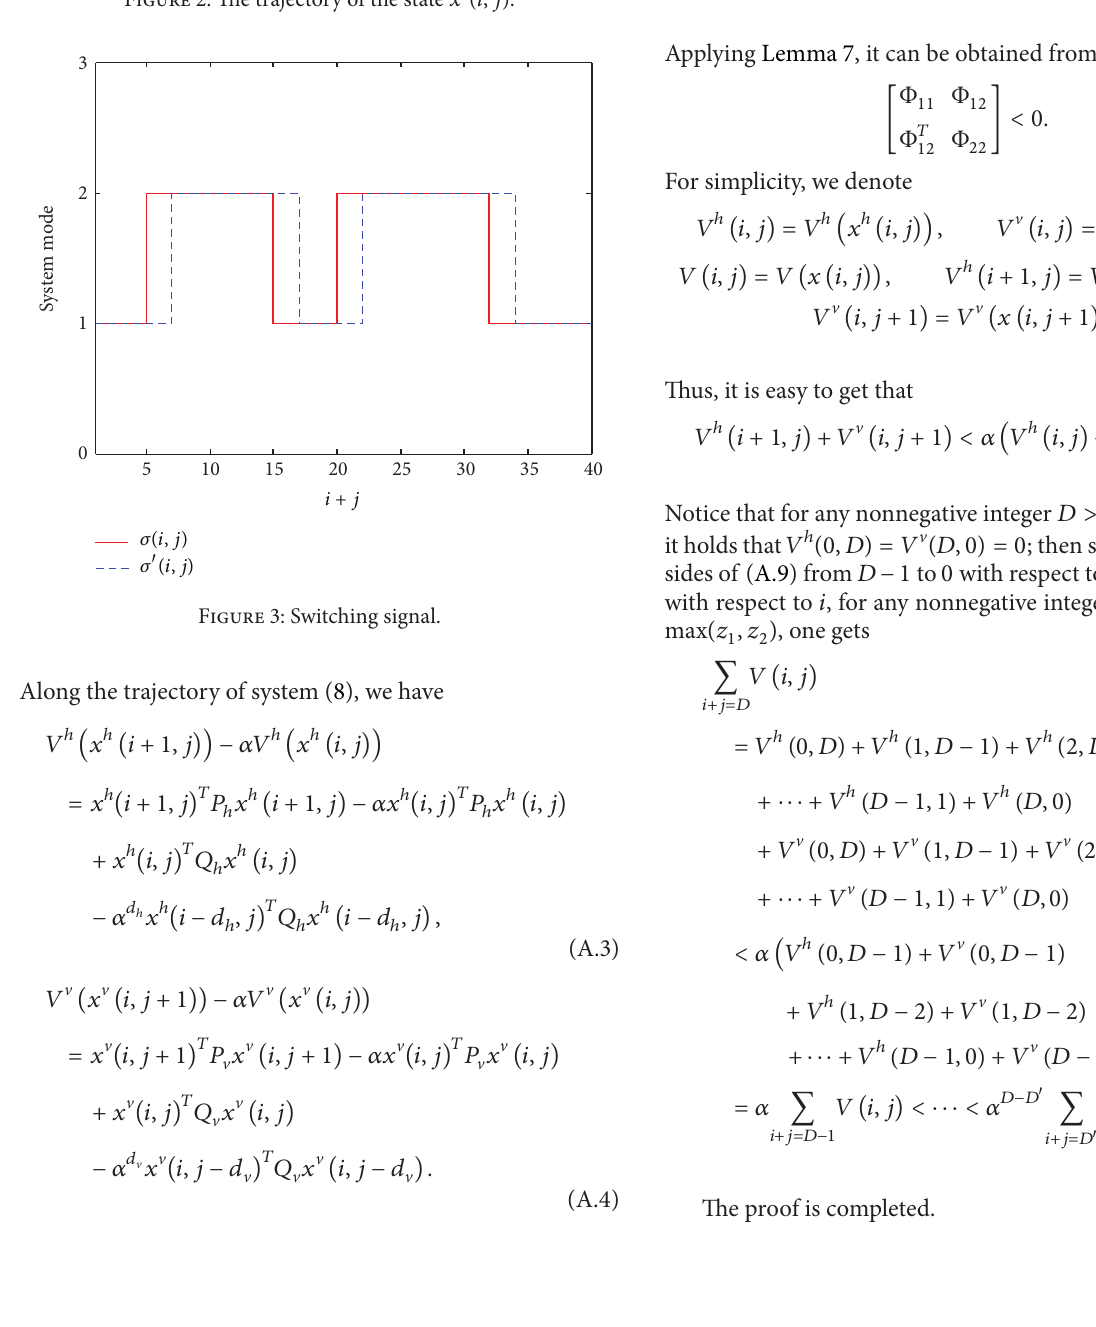
Figure 2: The trajectory of the state 𝑥 V (𝑖,𝑗) .